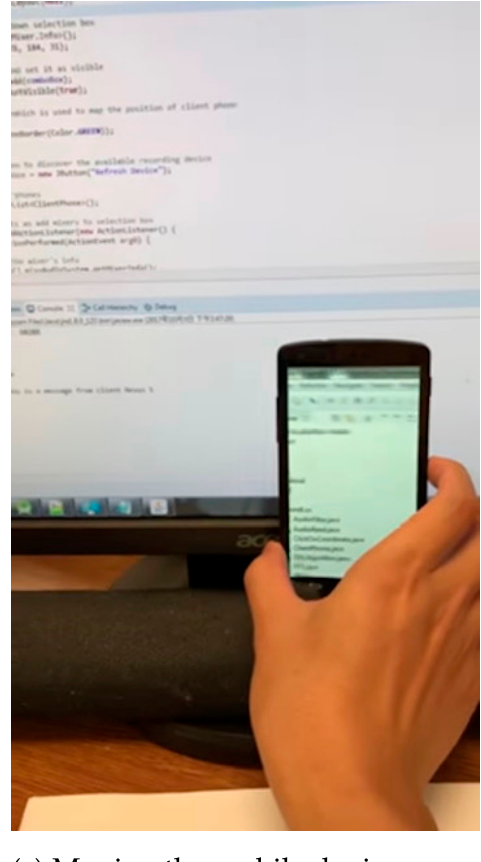
Figure 1. The cursor-position estimation system.